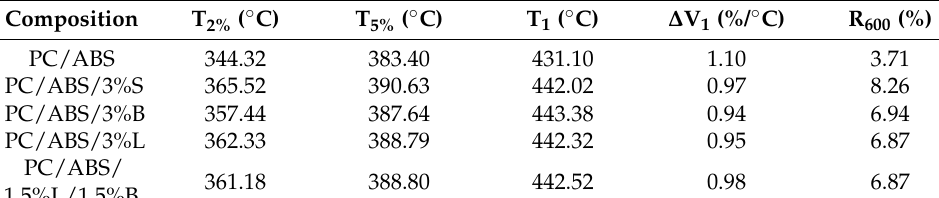
Table 4. The results of research on the properties of the thermostability of composites.